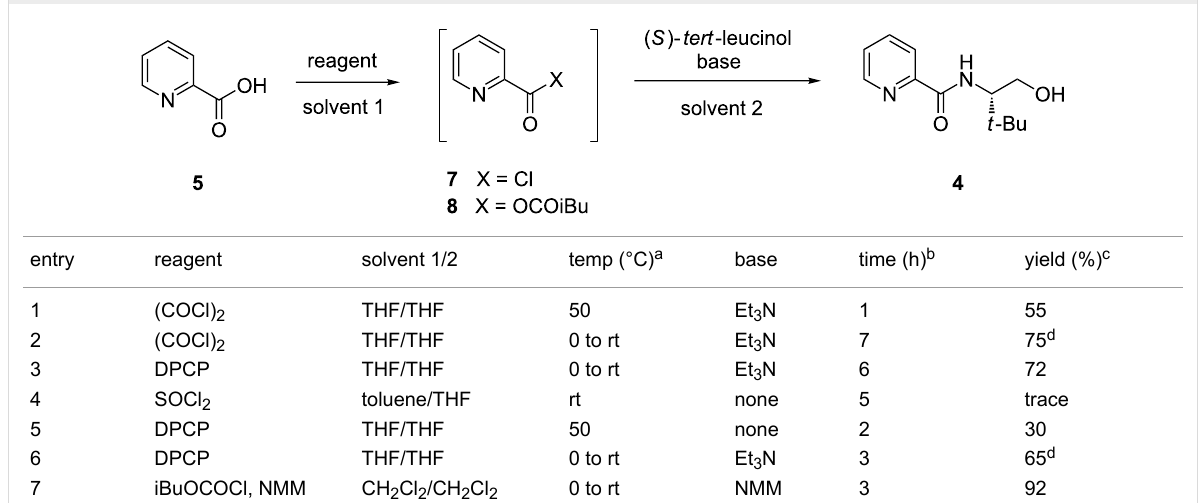
Table 1: Amidation reactions of picolinic acid.